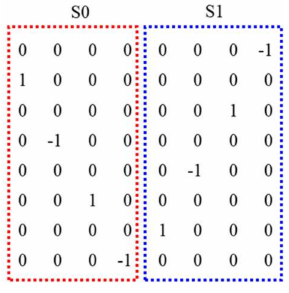
Figure 13. An example of resulting G matrix for N = 8 by Figure